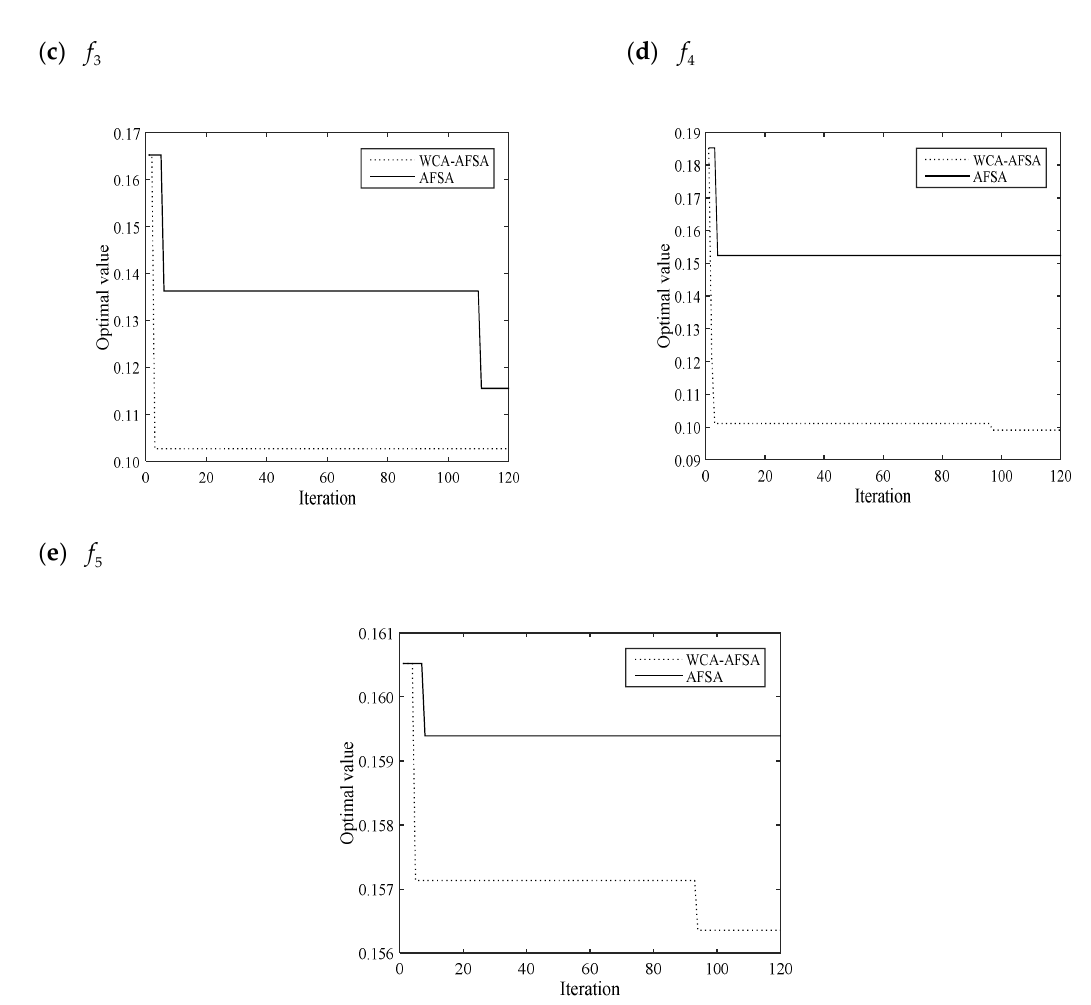
Figure 6 . Results comparison of WCA-AFSA with AFSA. Figure 6. Results comparison of WCA-AFSA with